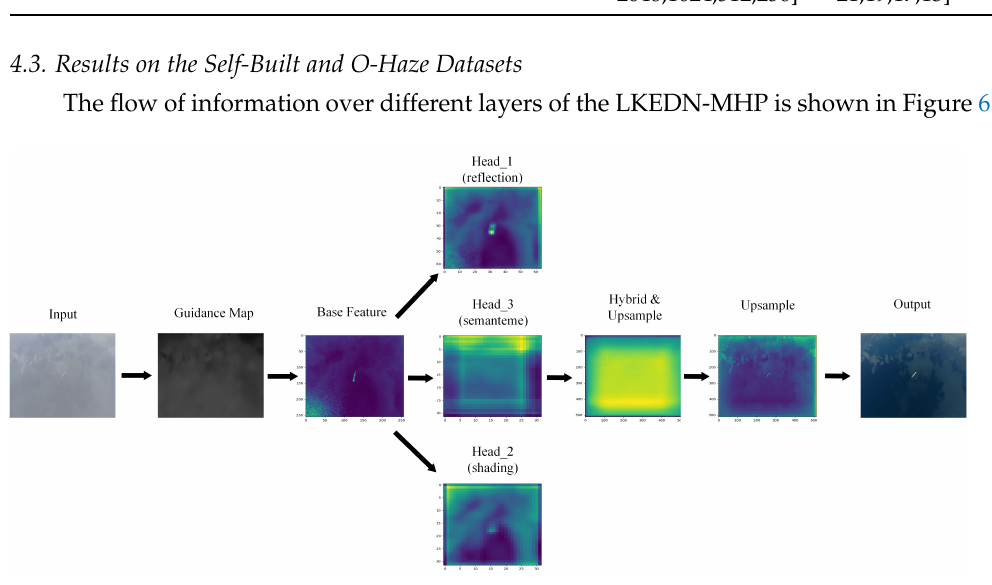
Figure 6. The flow of information over different layers of the